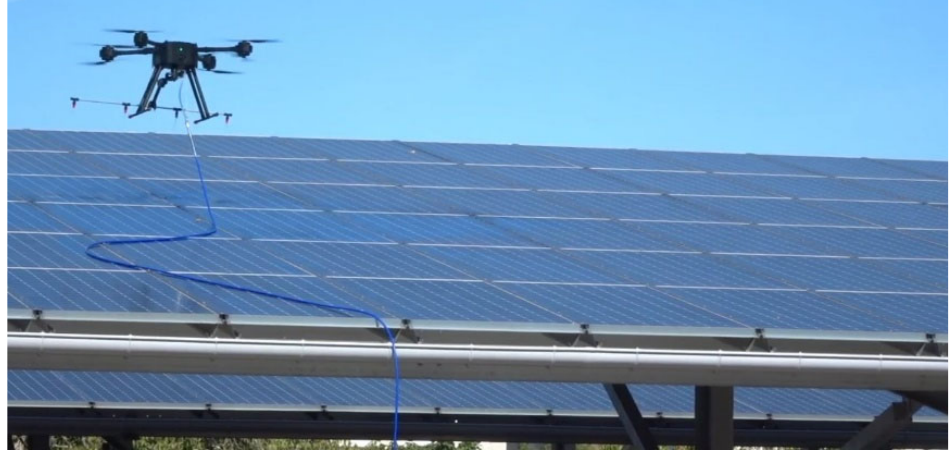
Figure 20. Solar panels cleaning using a spray drone [84].